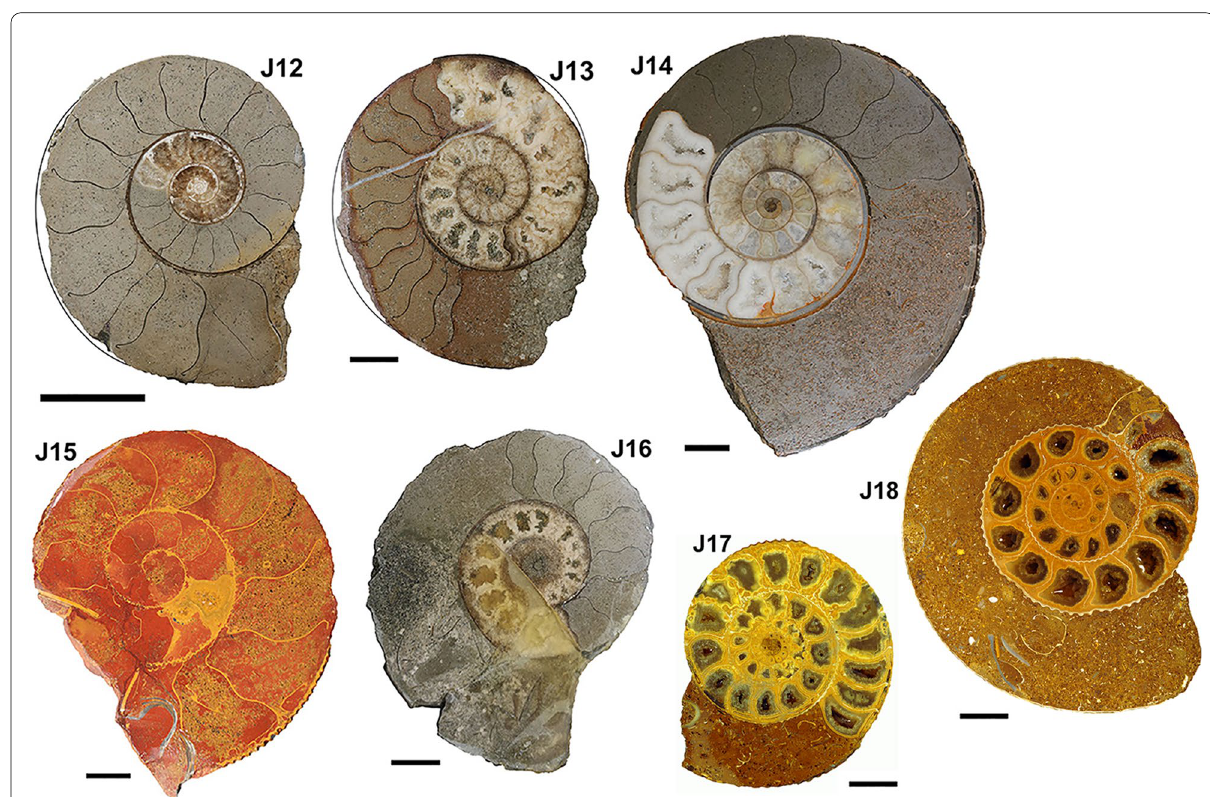
Fig. 3 Jurassic ammonoids, Aalenian to Oxfordian (for details see Table 1). (J12) Ludwigia bradfordensis (PIMUZ 19067), (J13) Staufenia opalinoides (PIMUZ 19087), (J14) Lud. bradfordensis (PIMUZ 2034), (J15) Macrocephalites compressus (PIMUZ 37667), (J16) Staufenia opalinoides (PIMUZ 19091; L/1026), (J17, J18) Divisosphinctes besairei (PIMUZ 37734, 37735). Scale bar